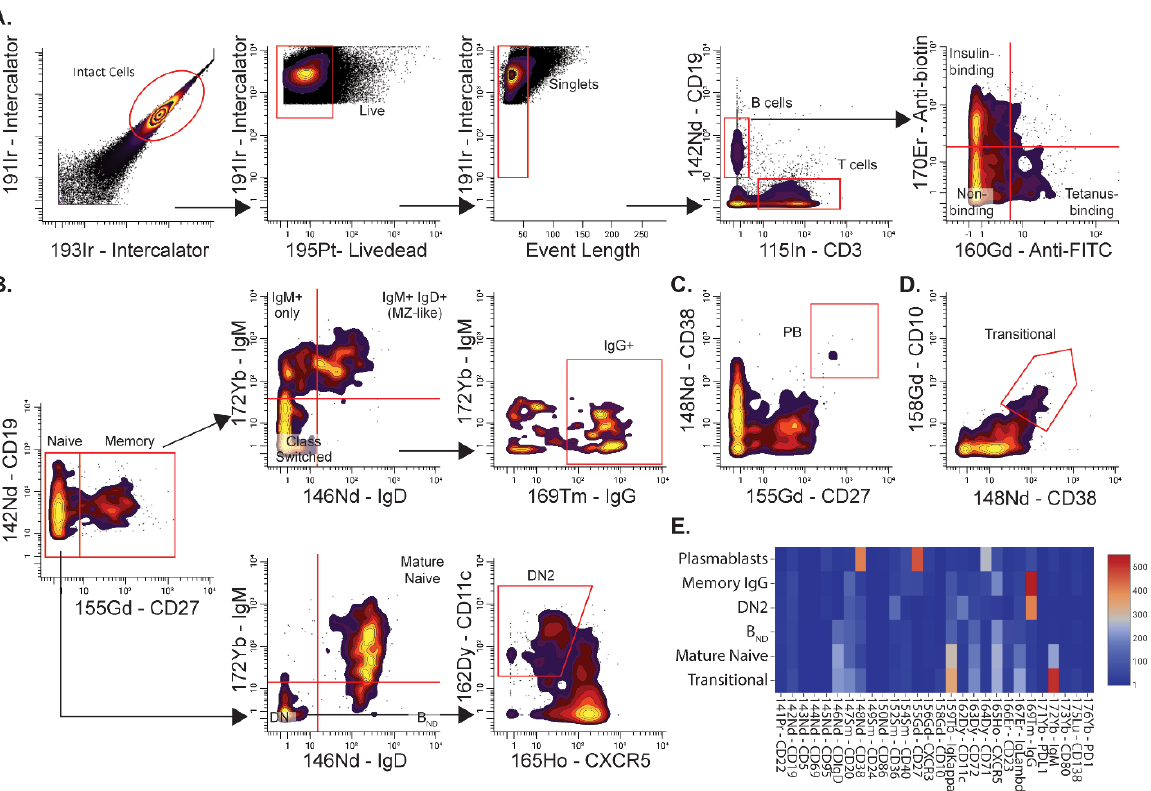
Figure 3. Representative manual gating strategy for identification of antigen-binding B cells and major B cell subsets. ( A ) Initial gating on intact cells, live cells, singlets, and then B cells to identify insulin and tetanus-binding B cells using mass cytometry. ( B ) Representative gating to identify major B cell subjects, including naïve (CD27-), memory (CD27+), CS-memory (CD27+ IgM- IgD-), Marginal zone (MZ) memory (CD27+ IgM+ IgD+), IgG+ memory (CD27+ IgG+), mature naïve (CD27- IgM+ IgD+), anergic B ND (CD27- IgMlo IgD+), double-negative (DN) (CD27- IgD-), and DN2 (CD27- IgD- CXCR5- CD11c+). Cells were initially gated on CD19+ cells. ( C ) Representative gating to identify plasmablasts (CD27hi CD38hi). Cells were initially gated on CD19+ cells. ( D ) Representative gating to identify transitional B cells (CD10hi CD38hi). Cells were initially gating on naïve B cells (CD19+ CD27-). ( E ) Representative heatmap of various cell surface markers expressed on manually gated B cell subsets. Colors represent raw mean metal intensities (MMI). Data were analyzed by